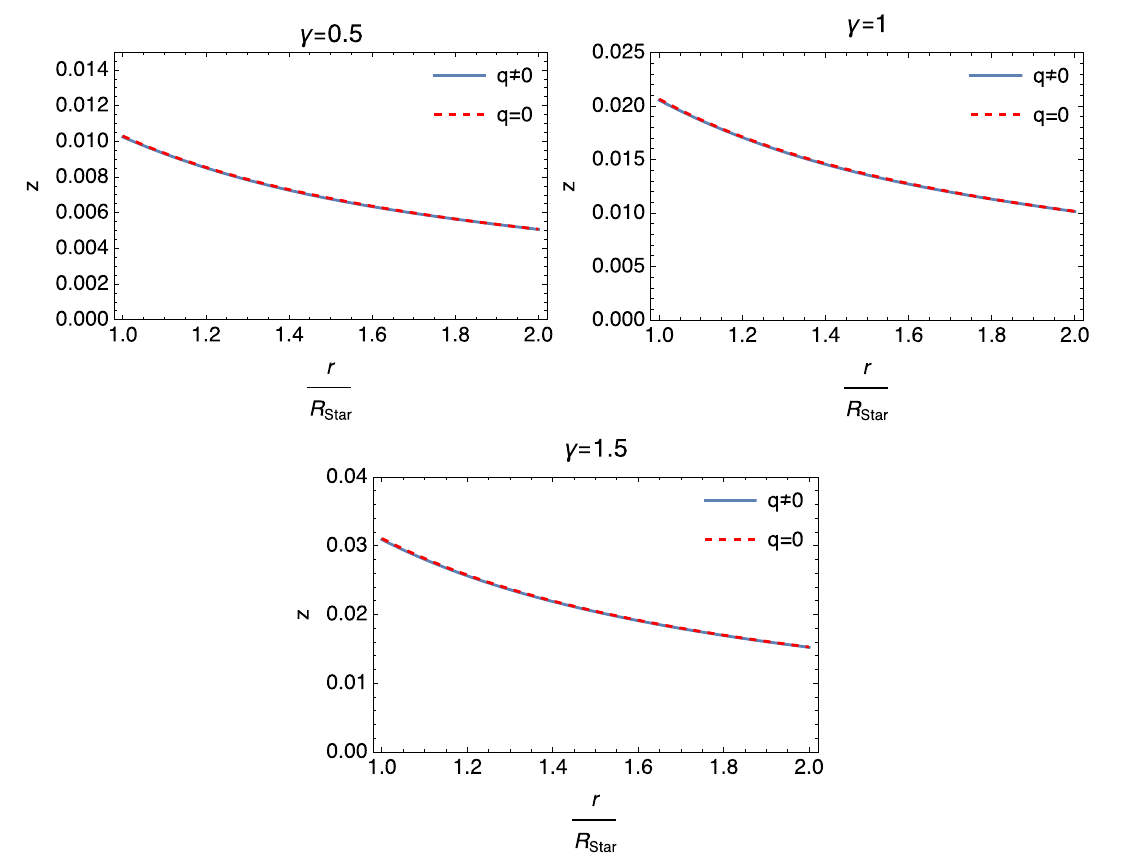
for the compact object SAXJ1808.4-3658. The plots are generated for static R Star